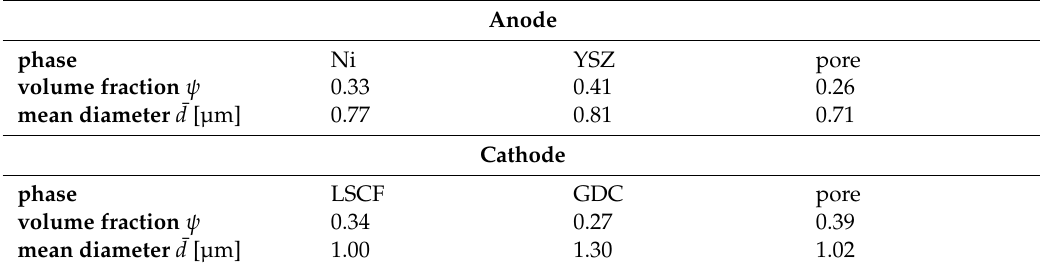
Table 5. Volume fractions and mean particle diameters of each